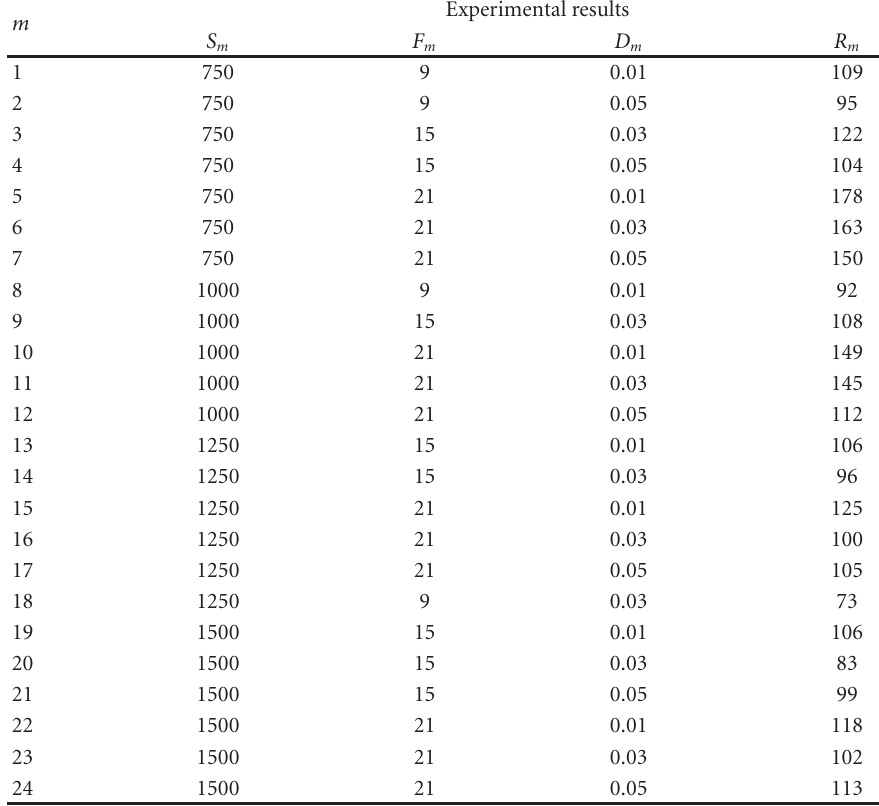
Table 4: Experimental results for testing data (Lo [12] and Ho et al. [13]).